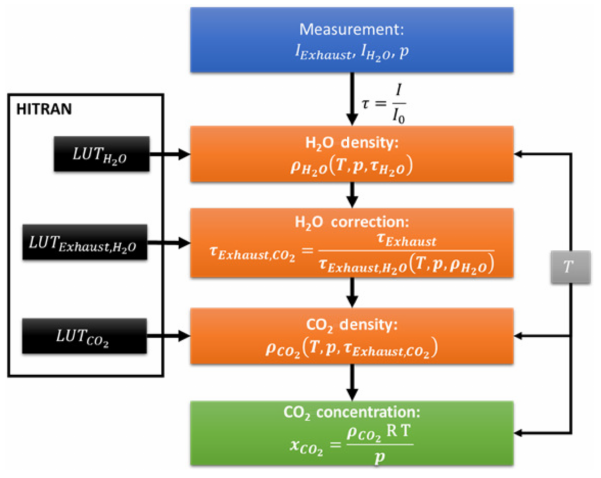
Figure 6. Schematic overview of the data analysis procedure for determination of CO 2 concentrations in IC engines by NDIR.